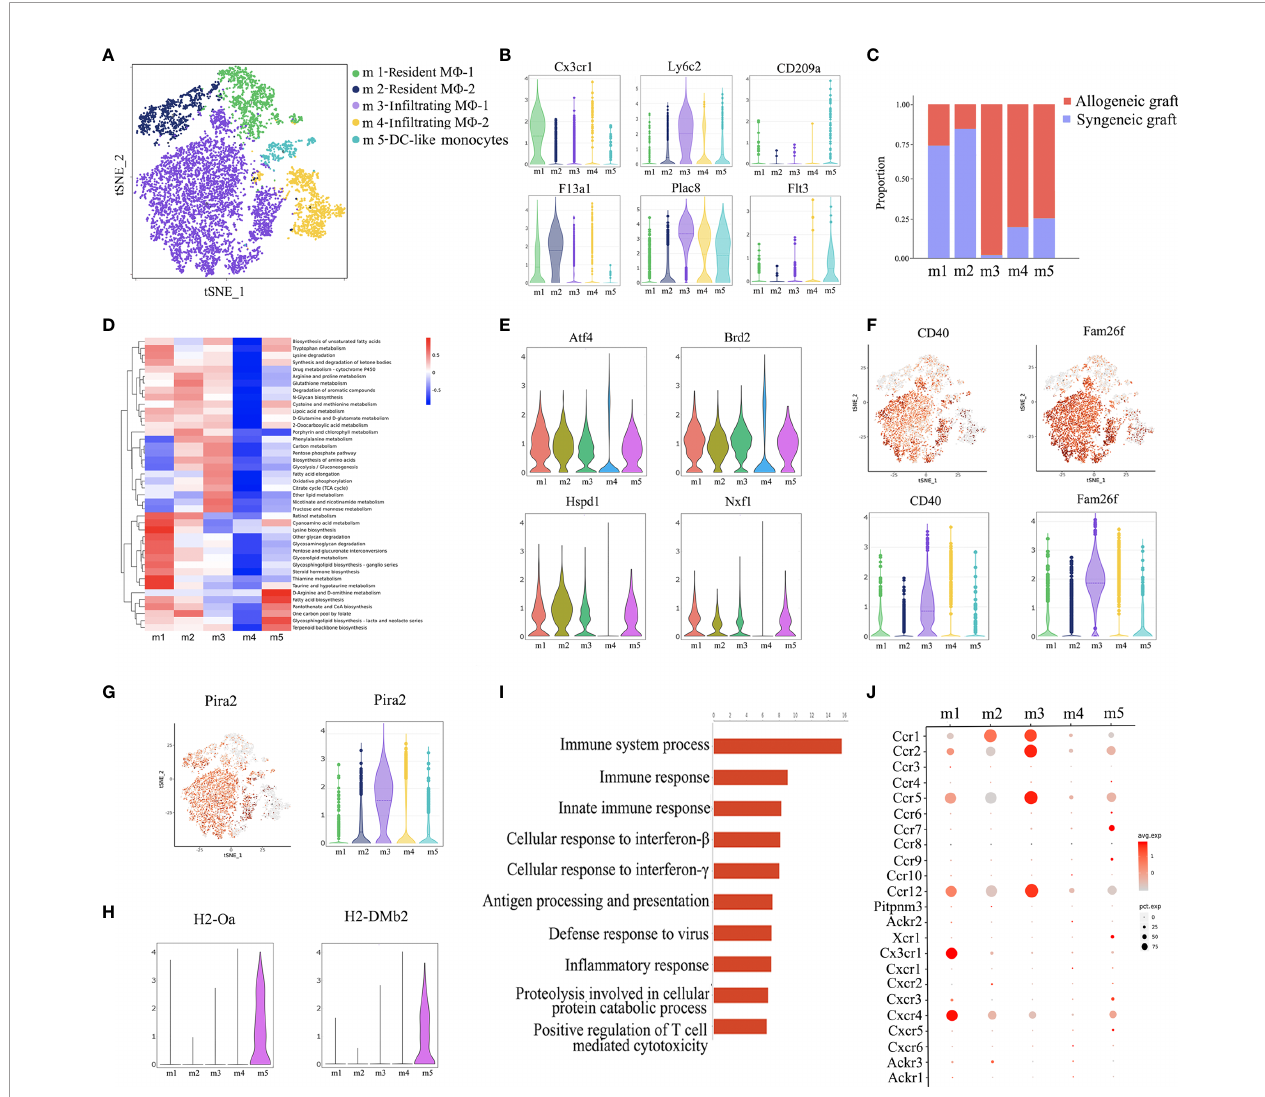
FIGURE 3 | Annotation of macrophage subsets. (A) t-SNE plot identifying fi ve distinct populations of macrophages from two allogeneic heart grafts and two syngeneic heart grafts. (B) Violin plots displaying the expression of representative markers across macrophage types (Cx3cr1 and F13a1 for resident macrophages, Ly6c2 and Plac8 for in fi ltrating macrophages, CD209a and Flt3 for dendritic cells). (C) Proportion of cells in each macrophage population from allogeneic or syngeneic graft. (D) Quantitative Set Analysis for Gene Expression (QuSAGE) analysis examining active cellular metabolic pathways in each macrophage population. (E) Violin plots displaying the expression of genes (Atf4, Brd2 Hspd1, Nxf1) associated with cell proliferation, metabolism and activation in each macrophage population. (F) t-SNE maps and violin plots indicating the expression of CD40 and Fam26f. (G) t-SNE maps and violin plots indicating the expression of Pira2. (H) Violin plots displaying the expression of MHC class II molecules H2-Oa and H2-DMb2. (I) GO Biological Process and Pathway Analysis of the m3 cluster. (J) A dot plot showing the expression of the chemokine receptor in macrophages